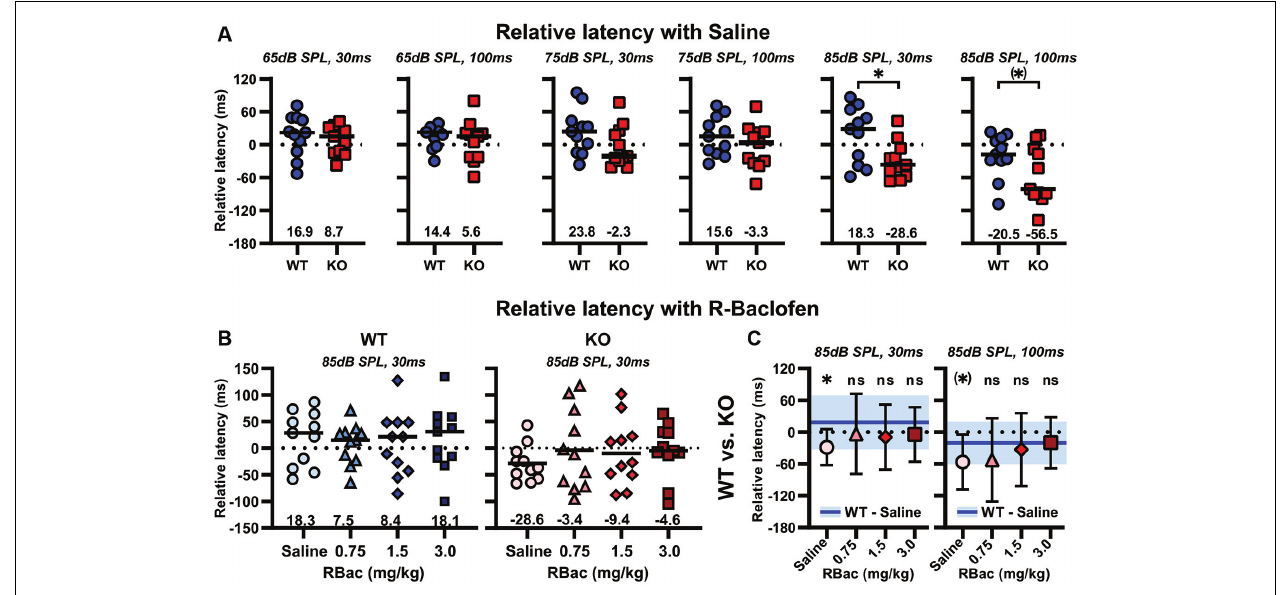
FIGURE 9 | R-Baclofen increases the relative latencies of startle in PPI trials (ms) in Cntnap2 KO rats compared with WT controls. (A) Relative latencies of startle in PPI trials for six different prepulse conditions with three stimulus levels at two different ISIs. Scatter plots depict individual relative latencies of startle in PPI trials for each prepulse condition and black horizontal lines represent the mean relative latency of startle. After saline injection, Cntnap2 KO rats (red squares) had consistently shorter relative latencies of startle in PPI trials than WT rats (blue circles), with a significant difference for the prepulse condition 85 dB SPL, 30 ms and a tendency for the prepulse condition 85 dB SPL, 100 ms (two-sided student’s t -test, from left to right: 65 dB SPL, 30 ms; p = 0.5569; 65 dB SPL, 100 ms; p = 0.5043; 75 dB SPL, 30 ms; p = 0.1335; 75 dB SPL, 100 ms; p = 0.2566; 85 dB SPL, 30 ms; p = 0.0195; 85 dB SPL, 100 ms; p = 0.0819). (B) Scatter plots depicting individual (symbols) and mean relative latencies of startle in PPI trials (black horizontal lines) for prepulse condition 85 dB SPL, 30 ms in Cntnap2 WT ( Left , blue) and KO rats ( Right , red) after injection of saline (circles), 0.75 mg/kg (triangles), 1.5 mg/kg (diamonds), and 3 mg/kg R-Baclofen (squares). R-Baclofen did not significantly increase relative latencies in Cntnap2 WT ( Left : WT, RM ANOVA, p = 0.9282, F = 0.1226). There was a slight, yet statistically not significant, increase in KO rats (Right : KO, RM ANOVA, p = 0.5611, F = 0.6374). (C, Left) Mean ± SD relative latency to prepulse condition 85 dB SPL, 30 ms in Cntnap2 KO rats was significantly different from WT controls (after saline, blue line and area) with saline (two-sided student’s t -test, p = 0.0195), and similar to controls with 0.75 mg/kg (two-sided student’s t -test, p = 0.4381), 1.5 mg/kg (two-sided student’s t -test, p = 0.2627) and 3 mg/kg R-Baclofen (two-sided student’s t -test, p = 0.3069). (C, Right) Mean ± SD relative latency to prepulse condition 85 dB SPL, 100 ms in Cntnap2 KO rats was by tendency different from WT controls (after saline, blue line and area) with saline (two-sided student’s t -test, p = 0.0819), and similar to controls with 0.75 mg/kg (Welch’s t -test, p = 0.2479), 1.5 mg/kg (two-sided student’s t -test, p = 0.6028) and 3 mg/kg R-Baclofen (two-sided student’s t -test, p = 0.9833). Dotted horizontal lines at 0 Relative Latency (ms) represent similar latency to the maximum startle response in trials with vs. without a prepulse. ( ∗ ) p < 0.1, ∗ p < 0.05; n.s.: not